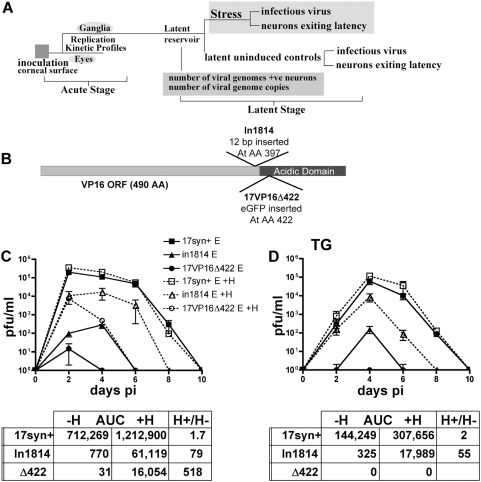
Replication kinetics of the VP16 transactivation mutants in1814 and
17VP16Δ422.(A) A schematic of the experimental design employed to biologically
characterize the VP16 mutants is shown. (B) A diagram of the genomic
structures of in1814 and 17VP16Δ422 is shown. (C,D) Mice were
infected as detailed in Methods
and, at the indicated times pi, tissues from three mice from each group
were assayed for infectious virus. Solid lines represent titers obtained
by standard plaque assay, whereas dashed lines represent the same
samples titrated in the presence of 3 mM HMBA, as described in Methods. The area under the curve
(AUC) was calculated for each curve, and the fold increase in AUC in the
presence of HMBA is indicated below the graphs. Genomically restored
isolates of both in1814 (1814R) and 17VP16Δ422
(17VP16Δ422R) were analyzed and found to be not different from
the parental strain, 17syn+ (not shown).